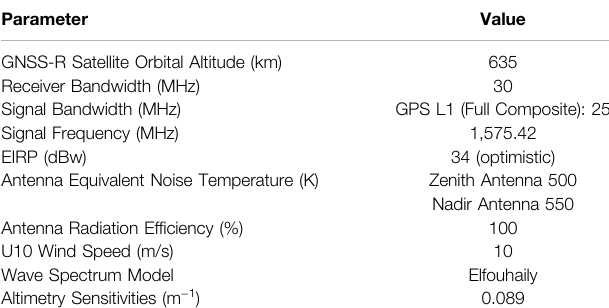
TABLE 3 | System and instrument parameters of the simulated spaceborne iGNSS-R altimeter. Parameter